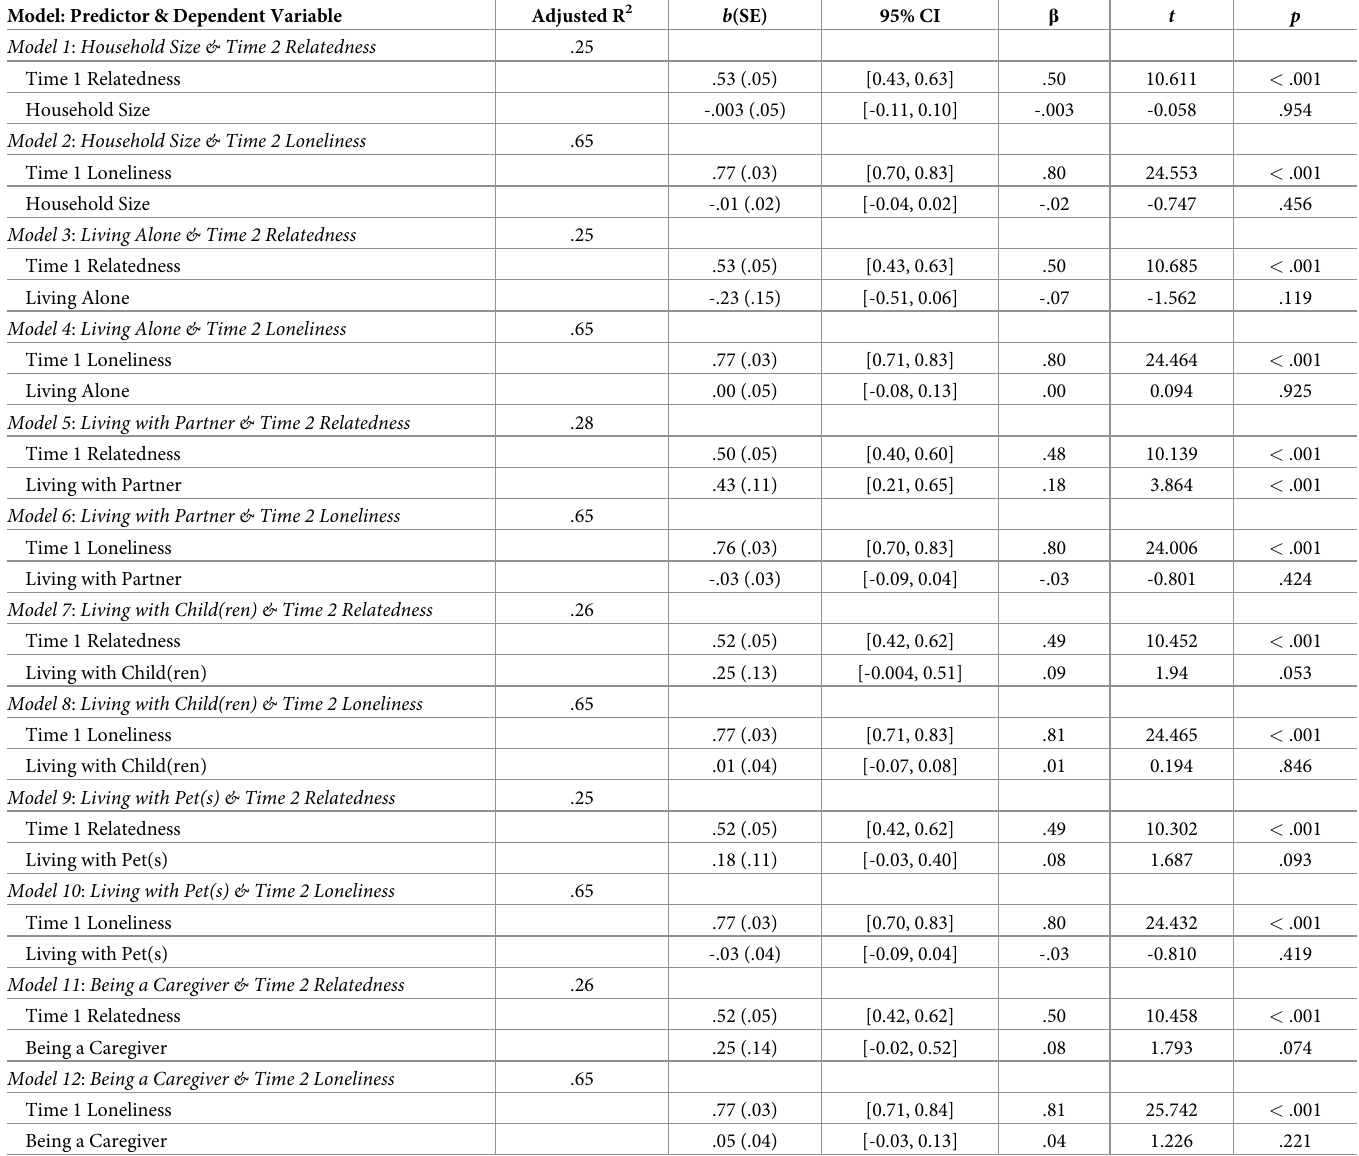
Table 6. Results of multiple regression models (Study